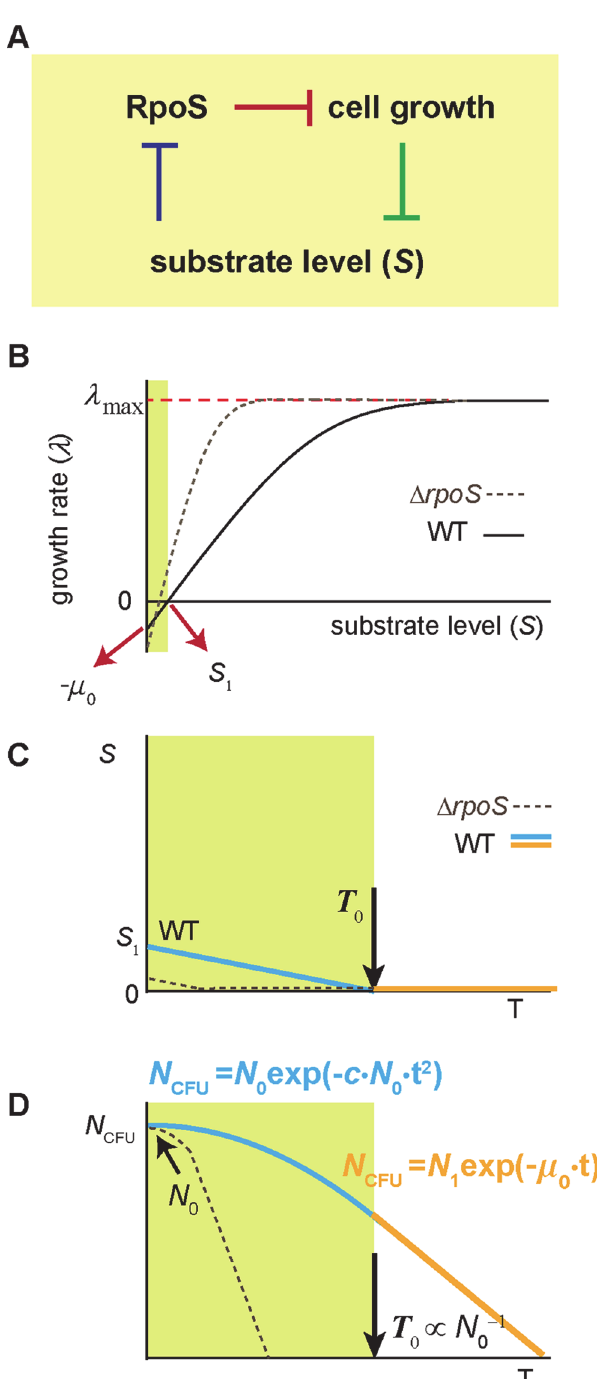
Fig 4. A mechanistic account of the density-dependent, biphasic survival kinetics. (A) Cells consume substrates for cell growth and the substrate concentration decreases in the medium (green line). When the concentration decreases to the levels affecting the rate of cell growth, RpoS accumulates (blue line) [26,27]. RpoS represses cell growth (red line) [30 – 32], forming negative feedback. In the feedback scheme, at low substrate levels, RpoS strongly represses cell growth and hence, substrate consumption, allowing cells to conserve a small amount of the substrate before it is completely depleted by cell growth. See the text for details. (B) This feedback predicts that as the substrate concentration is reduced, the growth arrest occurs at a non-zero substrate concentration S 1 , i.e., λ = 0 at S = S 1 > 0. This prediction agrees with previous